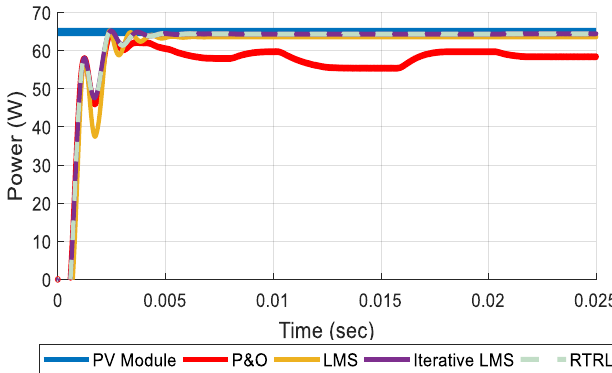
Figure 11. Results of the P&O, LMS, and RTRL controllers for 1000 W/m 2 and 25 °C.